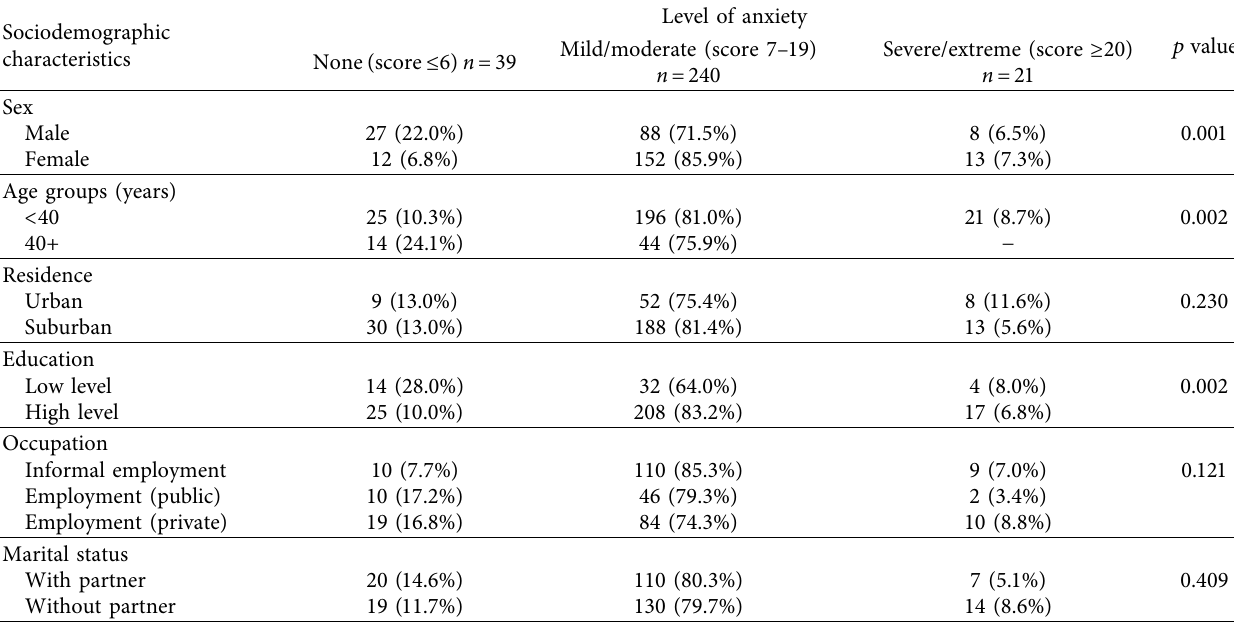
Table 5: Level of anxiety according to social-demographic characteristics of the